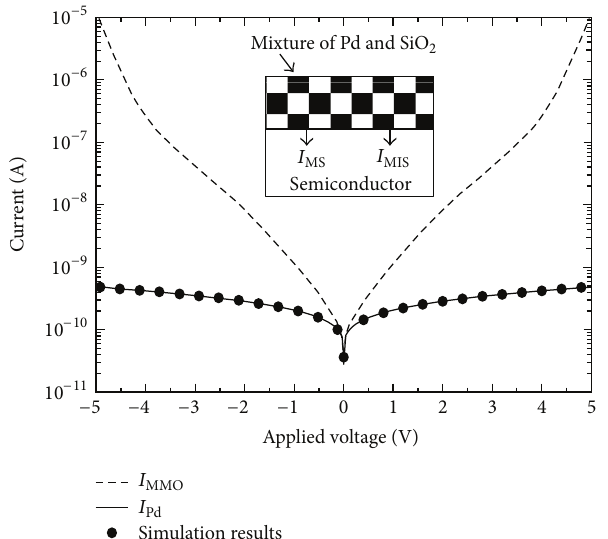
Figure 2: Current-voltage characteristics for Pd-mixture-GaAs and Pd-GaAs MSM diodes. Inset diagram is the schematic view of mixture of Pd and SiO 2 deposited upon the semiconductor